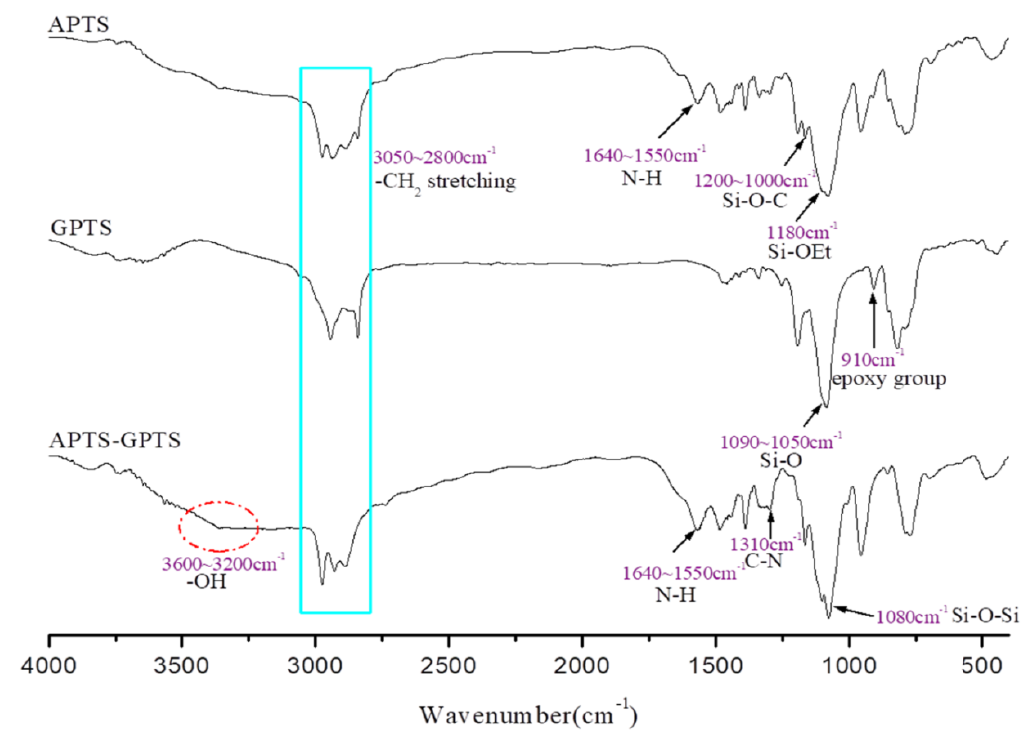
Figure 3. FTIR spectra of APTS, GPTS and APTS-GPTS.